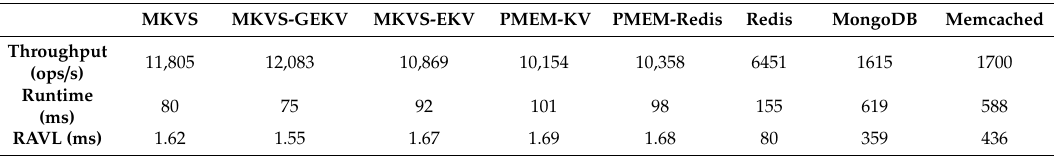
Table 3. The performance with read-intensive workload.